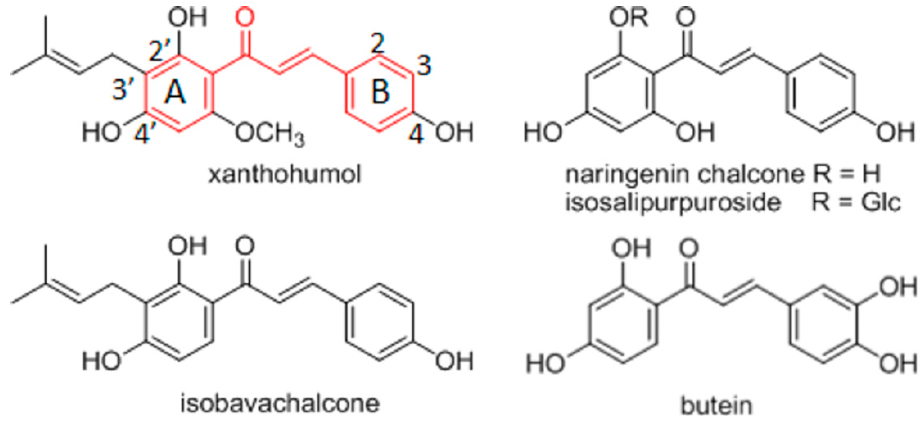
Figure 1. Natural chalcone antioxidants [1]. The 1,3-diphenylprop-2-en-1-one fragment is marked red and the atom numbering used for all studied compounds is labelled.